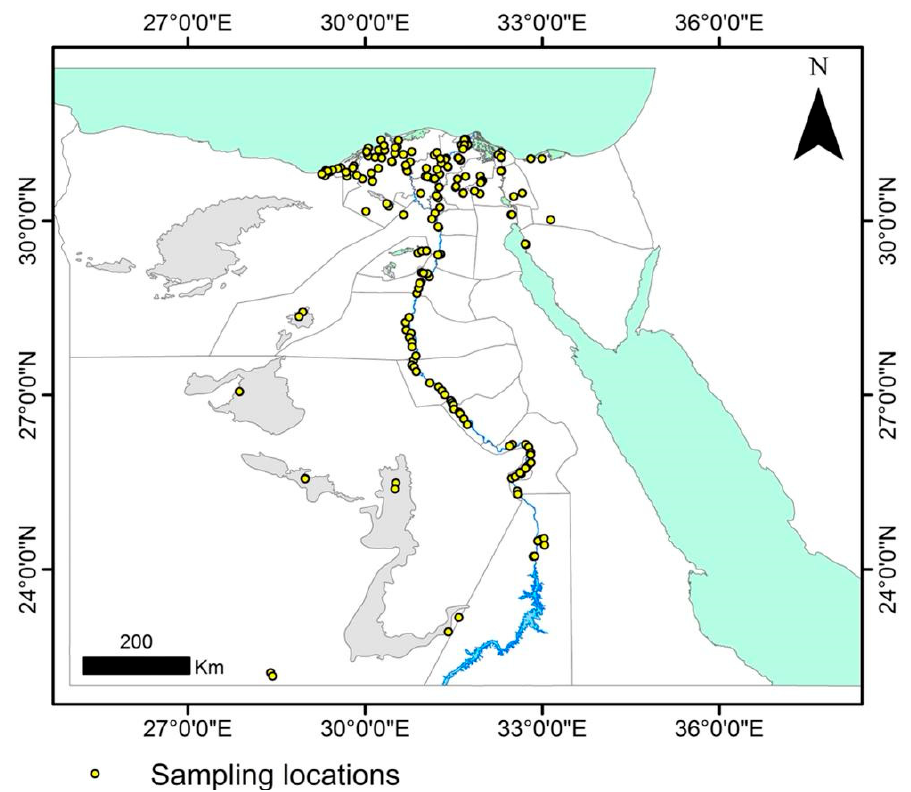
Figure 1. Locations (yellow dots) where maize grains were sampled from 25 maize-growing gover- norates of Egypt.